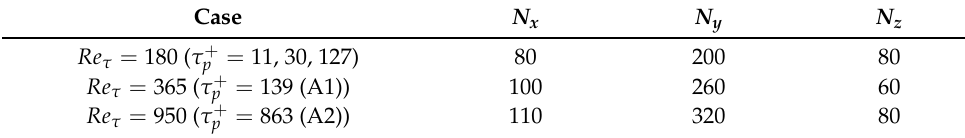
Table 7. Mesh size, in terms of number of cells, used in the numerical